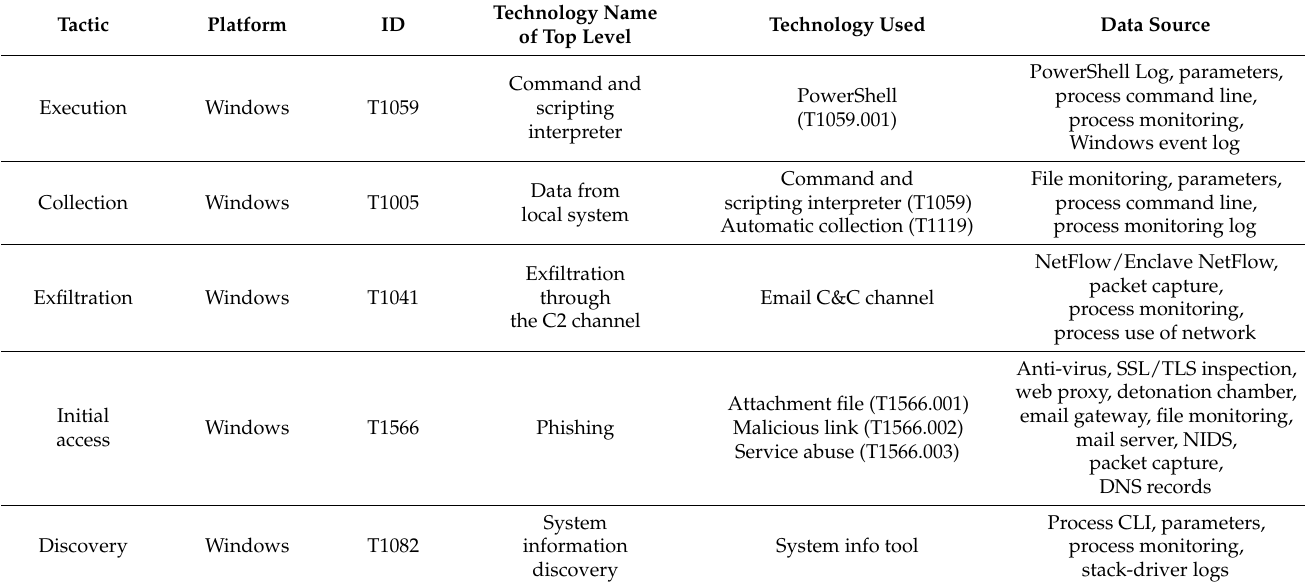
Table 4. ATT&CK-based attack technology exploited by Kimsuky.